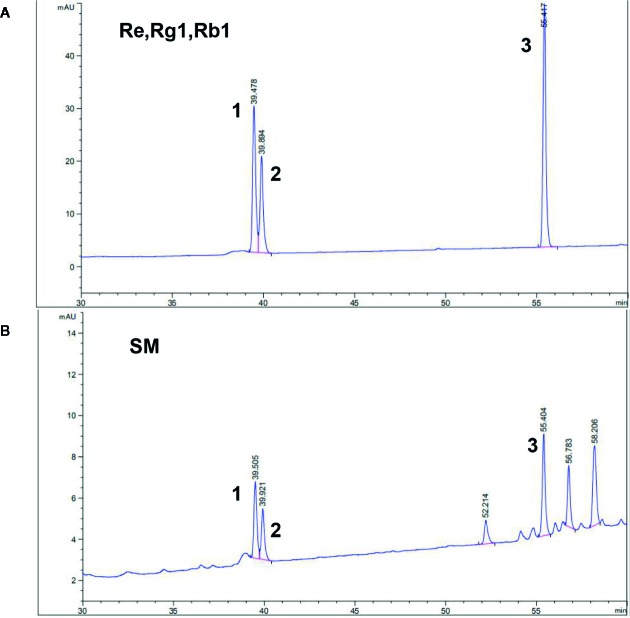
HPLC fingerprint of Shenmai injection and the ginsenosides Re, Rg1, and Rb1 as reference standards. A. Chromatogram of the reference standards: 1 represents ginsenoside Re; 2 represents ginsenoside Rg1; 3 represents ginsenoside Rb1. B. Representative chromatogram of Shenmai injection samples: No. 1–3 represent the common peaks with the reference standards Re, Rg1, and Rb1.